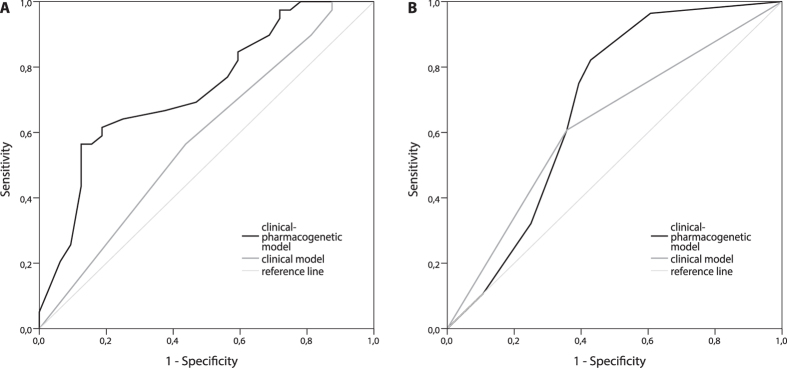
Receiver operating characteristic curve for predicting gemcitabine (A) and pemetrexed (B) treatment outcome in the training group for clinical-pharmacogenetic model and clinical parameters.